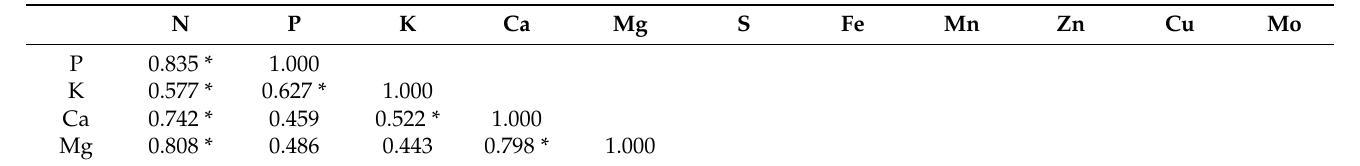
Table 3. Pearson’s correlation matrix between nutrient concentrations in young tomato leaves